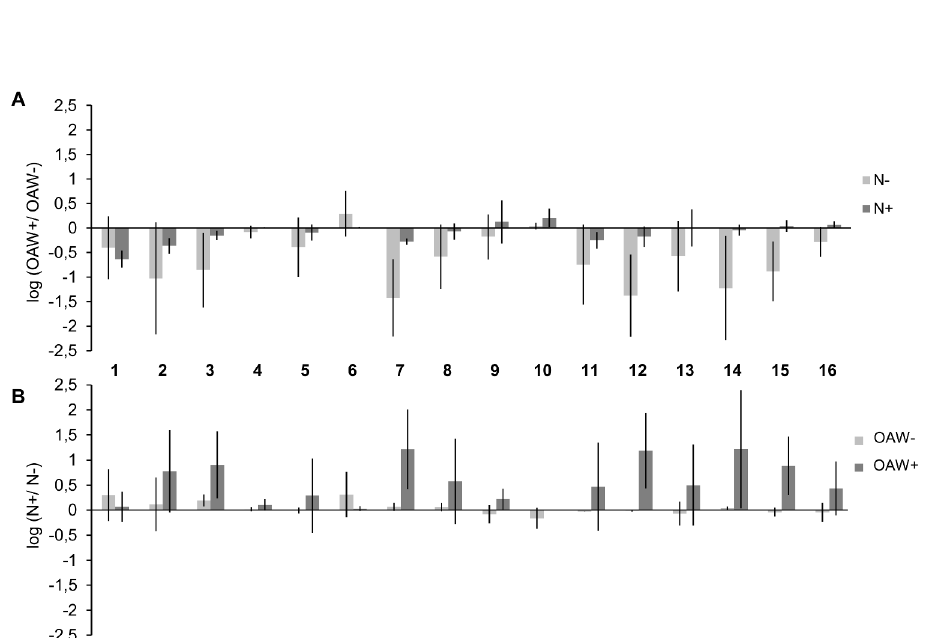
Fig 4. Log effect ratios of survival in 16 sibling groups during the OAW x nutrient experiment. Log effect ratios (mean ± 95% confidence intervals, n = 3) of (A) OAW effects were calculated as log (survival OAW+/ survival OAW-) under ambient and high nutrient conditions (N-, N+); (B) log effect ratios for nutrient effects were calculated as log (survival N+/ survival N-) at ambient and high OAW (OAW-, OAW+).